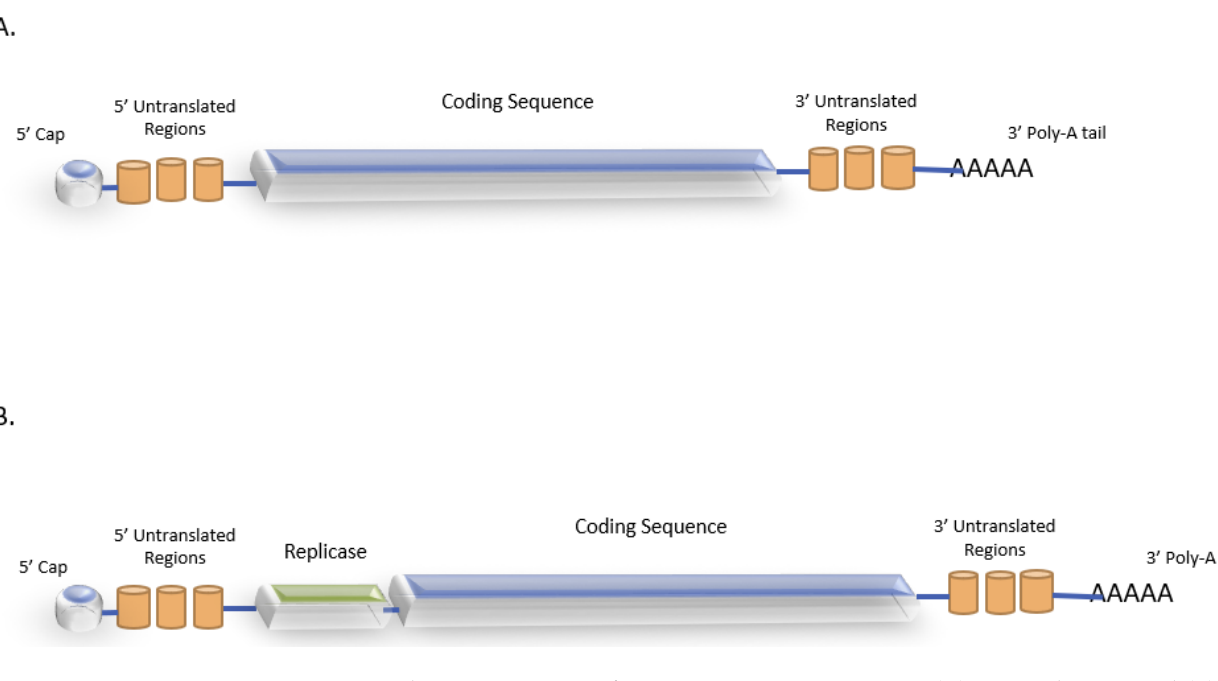
Figure 2. Schematic structure of an mRNA vaccine construct: ( A ) non-replicating and ( B ) self-replicating, 5 ′ cap—all eukaryotic mRNA has a cap that contains an m7GpppN structure, preserved throughout evolution. The cap structure not only prevents degradation, but also assists in binding with the eIF to activate translation. Untranslated regions regulate the translational efficiency, whereas the coding sequence contains codons that encode the gene of interest. The poly-A tail acts to maintain the stability of the RNA molecule [37–40].